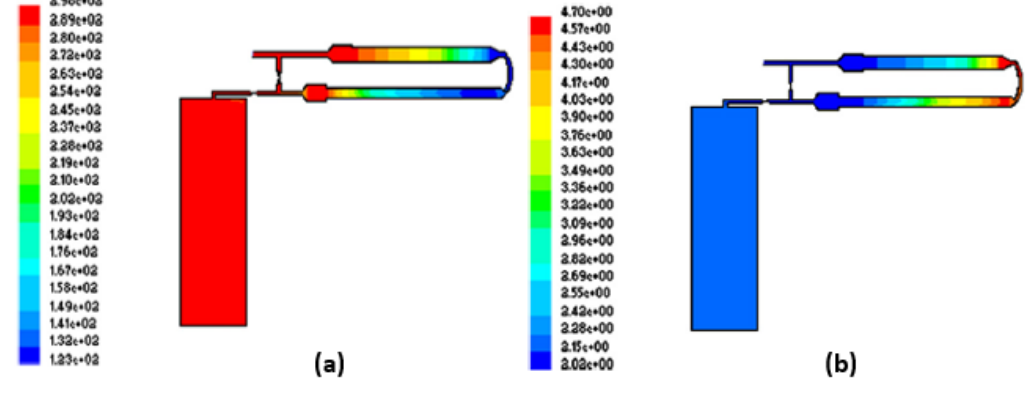
Figure 8. ( a ) Temperature contour; ( b ) density contour.